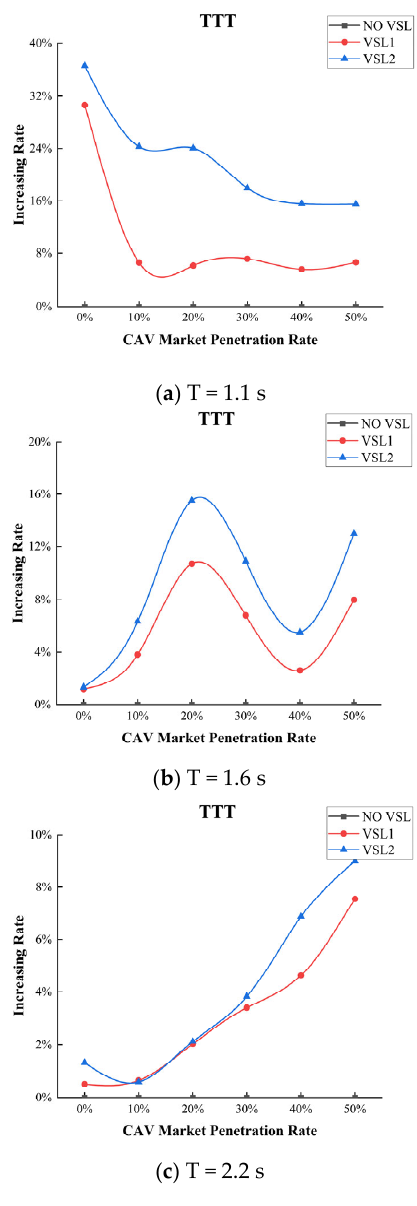
Figure 6. Results of efficiency evaluation. Note that the curves of NO ‐ VSL are overlapped with the x ‐ axis.